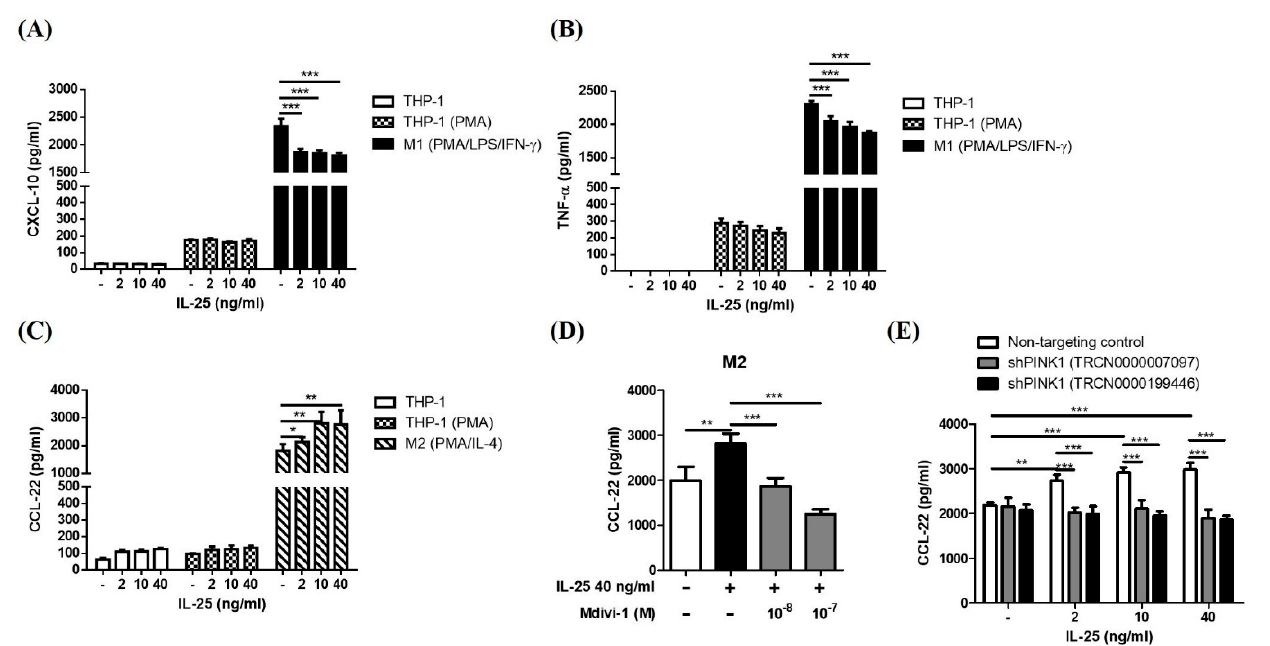
Figure 6. IL-25-induced mitophagy was associated with a shift in M2 macrophage polarization. THP-1 cells were pretreated with medium alone or IL-25 (2, 10, and 40 ng/mL) for 2 h and differentiated to THP-1 derived macrophages (PMA), M1 (PMA/LPS/IFN- γ ), or M2 (PMA/IL-4) macrophages. The concentration of M1-related chemokine CXCL-10 ( A ) and cy-tokine TNF- α ( B ) and M2-related cytokine CCL-22 ( C ) were measured. After pretreatment with solvent control (0.1% DMSO) or mdivi-1 ( D ), or knockdown PINK1 ( E ), the IL-25-induced CCL-22 production was assessed. * p < 0.05, ** p < 0.01, and *** p < 0.001; n = 3, means ± SD.